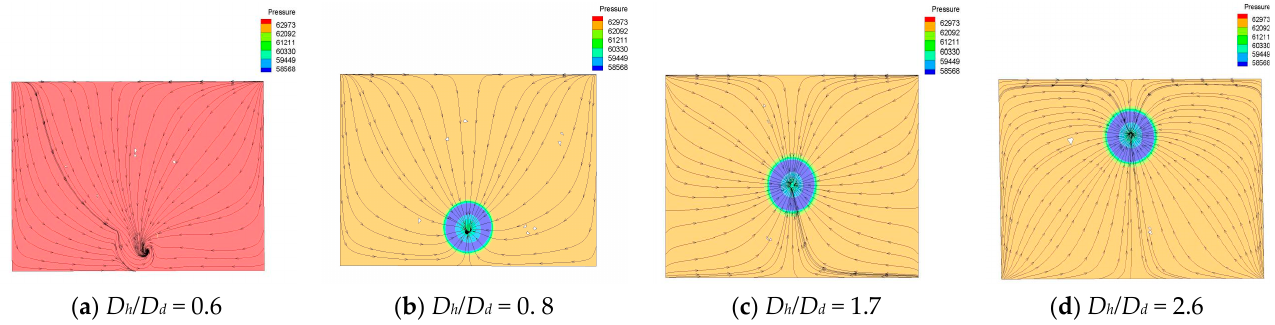
Figure 9. Suction sump flow line and pressure distribution diagram (section 3 - 1, unit:pa).